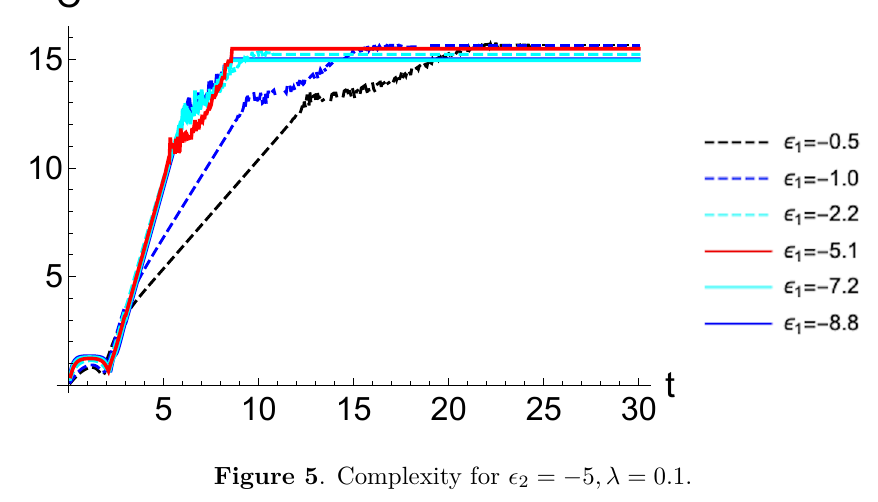
Figure 5 . Complexity for (cid:15) 2 = − 5 , λ = 0 . 1 .